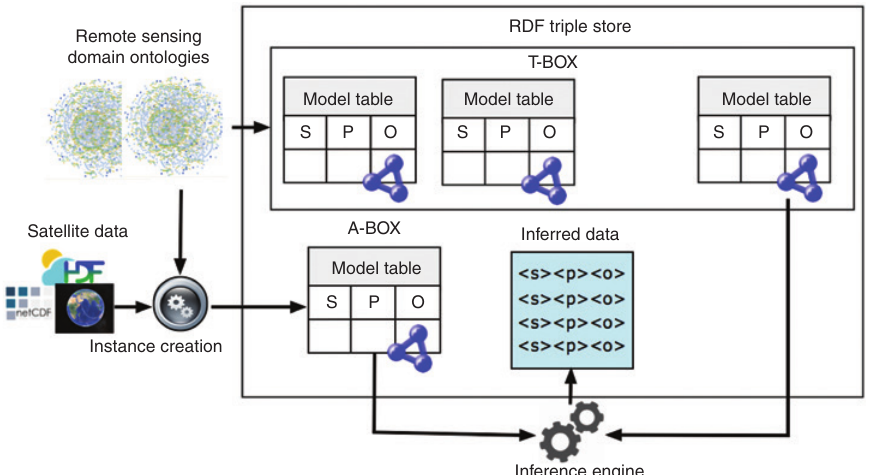
Figure 5: Strategy 3: Ontology Concept-Based Satellite Data